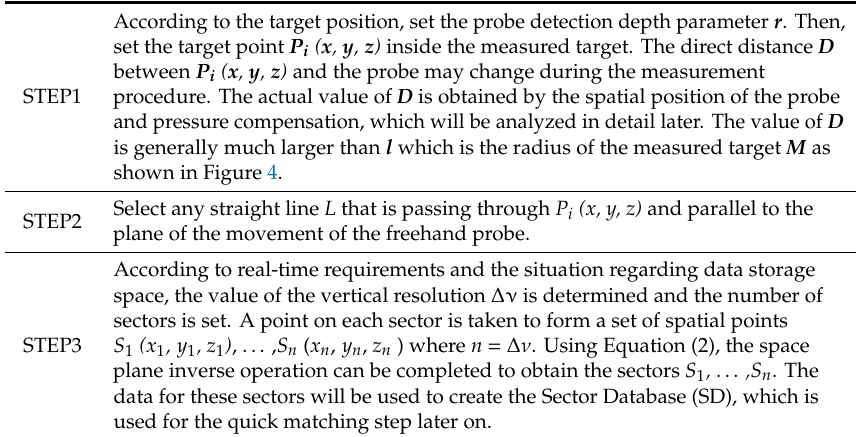
Table 1. Steps of space plane inverse